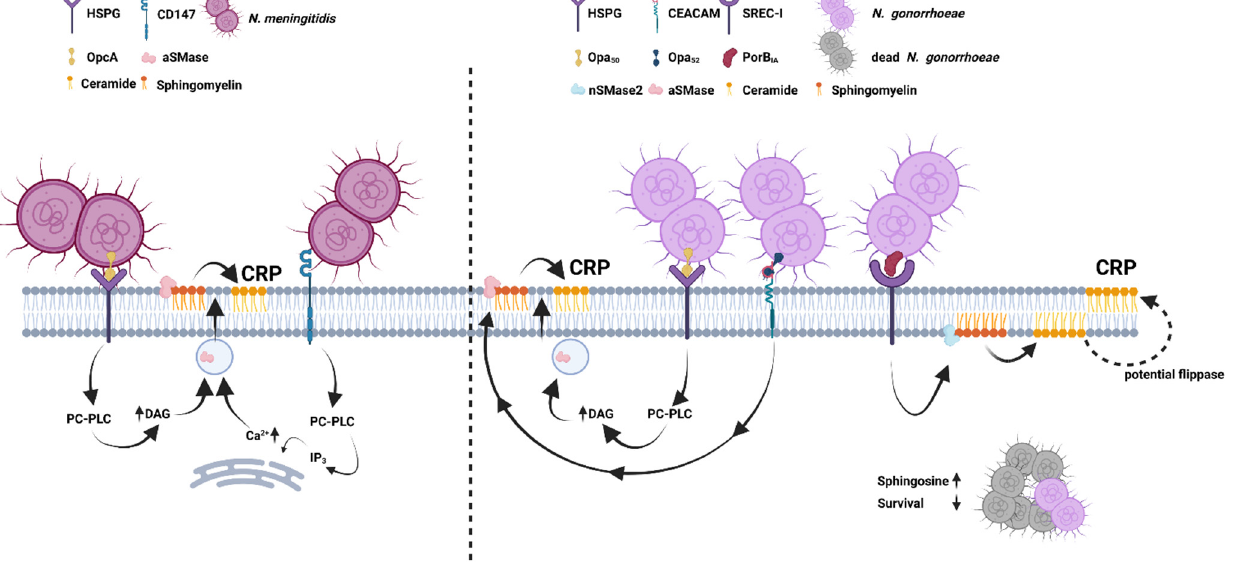
Figure 3. Schematic overview of interactions of N. meningitidis ( left panel) or N. gonorrhoeae ( right panel) with host cells and their impact on sphingolipid levels or enzymes of the sphingolipid pathway. HSPG: Heparan sulfate proteoglycane; aSMase: acid sphingomyelinase; CRP: ceramide rich platform; PC-PLC: phosphatidylcholine cholinephosphohydrolase; DAG: diacyl glycerides; IP3: inositol triphosphate; SREC-I: Scavenger receptor expressed by endothelial cells I; CEACAM: arcinoembryonic antigen-related cell adhesion molecule.